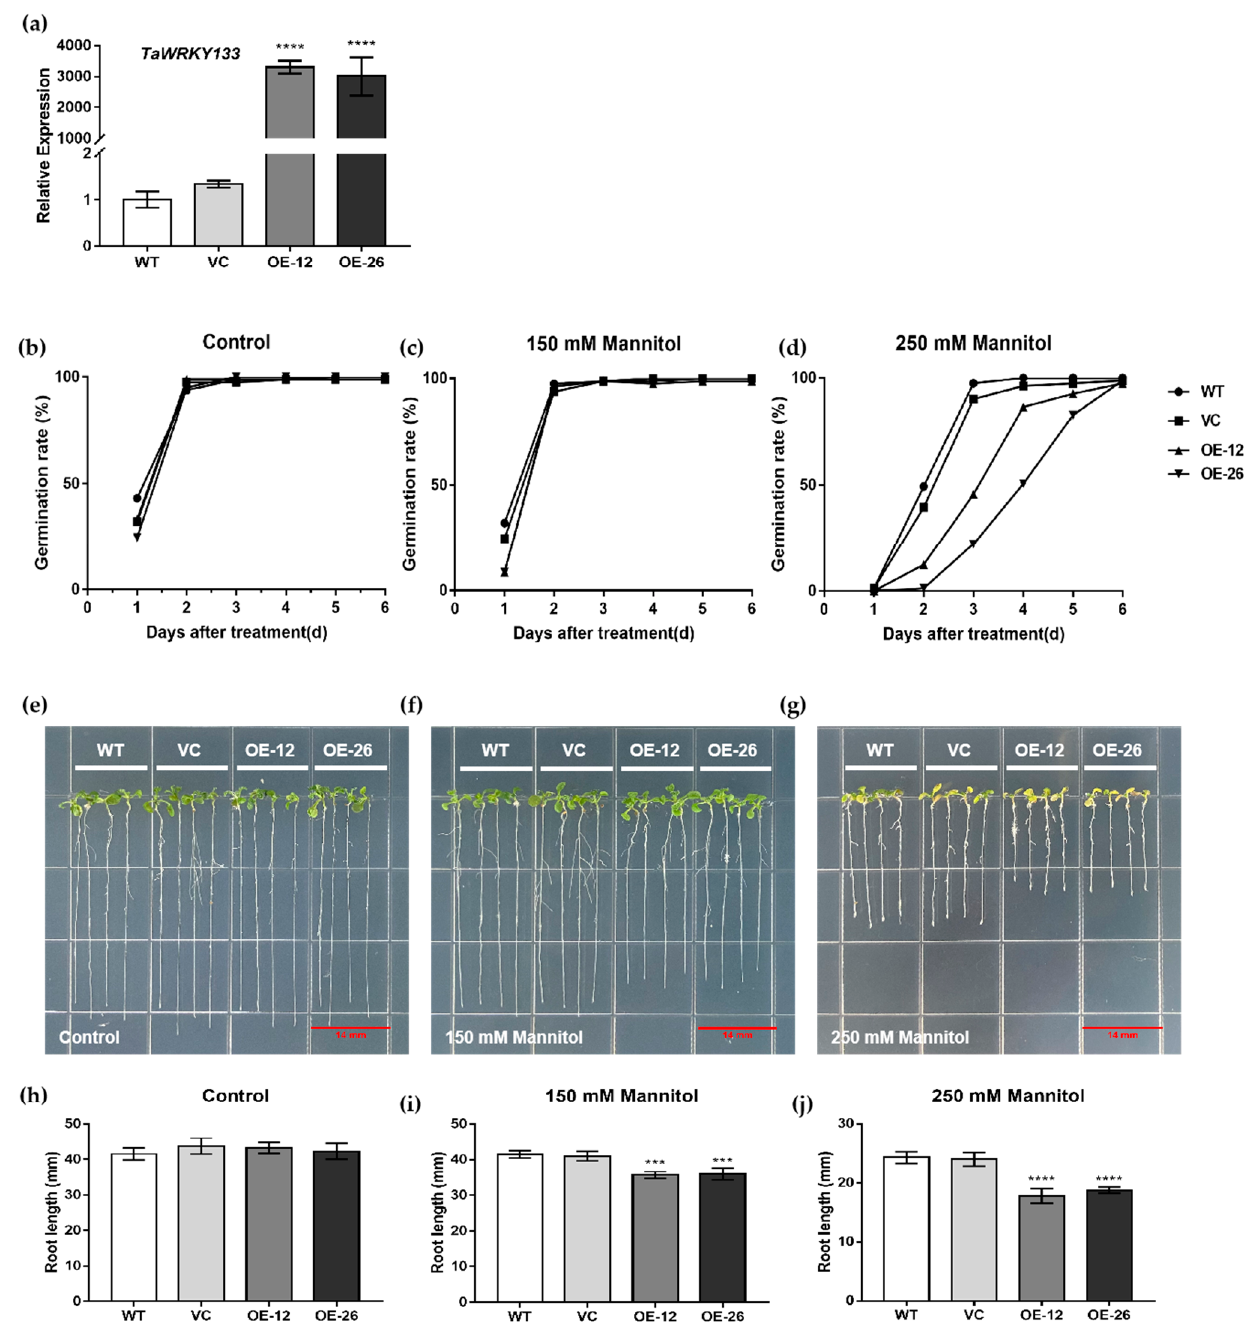
Figure 4. Mannitol treatment of TaWRKY133 overexpressing Arabidopsis thaliana . ( a ) Transgene validation of TaWRKY133 in OE lines by qRT–PCR. ( b – d ) Germination of TaWRKY133 OE lines on 1/2 MS plates containing mannitol (0 mM, 150 mM and 250 mM). ( e – g ) Root growth of TaWRKY133 OE lines on 1/2 MS plates containing mannitol (0 mM, 150 mM and 250 mM) and corresponding root lengths ( h – j ). Asterisks indicate significant differences (*** p < 0.001 and **** p < 0.0001). No asterisk means non-significant difference .